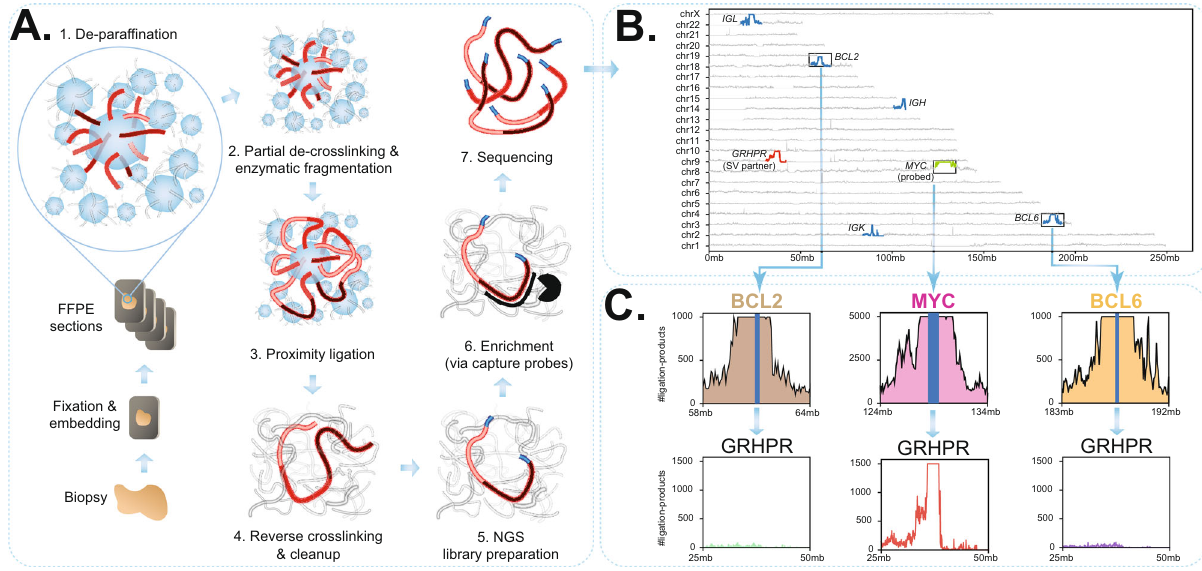
Fig. 1 Overview of FFPE-TLC and an example of the identi fi ed rearrangements. A Schematic overview of the FFPE-TLC work fl ow. (1) Through sample fi xation, spatially proximal sequences (red) are preferentially cross-linked. Next, paraf fi n is removed and the sample section is permeabilized to allow enzymes to access the DNA. (2) The DNA is fragmented using NlaIII and then (3) ligated, which results in concatenates of co-localizing DNA fragments. (4) After crosslink reversal and DNA puri fi cation, (5) the DNA is subjected to next-generation sequencing library preparation. (6) Sequences of interest are enriched using hybrid capture probes. (7) The prepared library is paired-end Illumina sequenced. B Genome-wide coverage of fragments retrieved from a typical FFPE-TLC experiment targeting MYC, BCL2, and BCL6. Shown in blue is the coverage seen at the (±5 Mb) genomic intervals targeted by the capture probes. The rearranged region to the MYC gene (in green) is identi fi ed by the concentration of fragments clustered around the GRHPR gene (chr9:31mb – 42mb), shown in red. C The probe sets used in FFPE-TLC not only retrieve the probe-complementary genomic sequences (in blue), but also megabases of its fl anking sequences (i.e., the proximity-ligation products), shown for MYC (pink), BCL2 (brown), and BCL6 (orange). In case of a rearrangement (MYC-GRHPR in this case), the corresponding capture probes also retrieve fragments originating from the rearrangement partner (GRHPR, in red). This is not the case for regions that do not harbor any rearrangement (e.g., BCL2 in brown or BCL6 in orange), as shown for the GRHPR